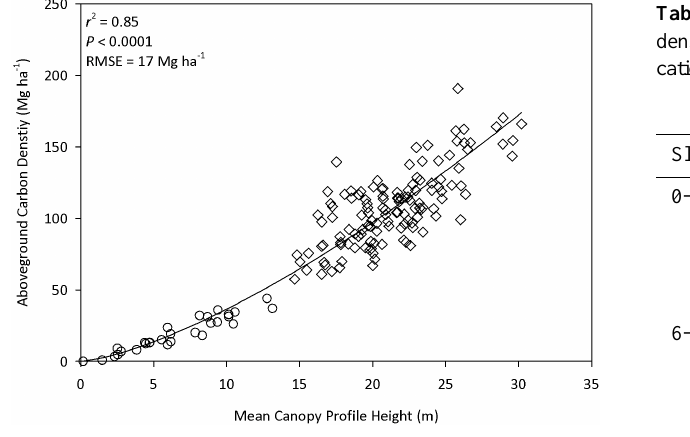
Fig. 3. Relationship between ground-based measurements of car- bon density (Mgha − 1 ) , and LiDAR-derived mean canopy profile height (MCH; m) for 29, 0.1-ha plots within STRI’s Agua Salud holdings (open circles), and 129, 0.36-ha plots within the 50-ha for- est dynamics plot on BCI (open diamonds). RMSE is the root mean square error.